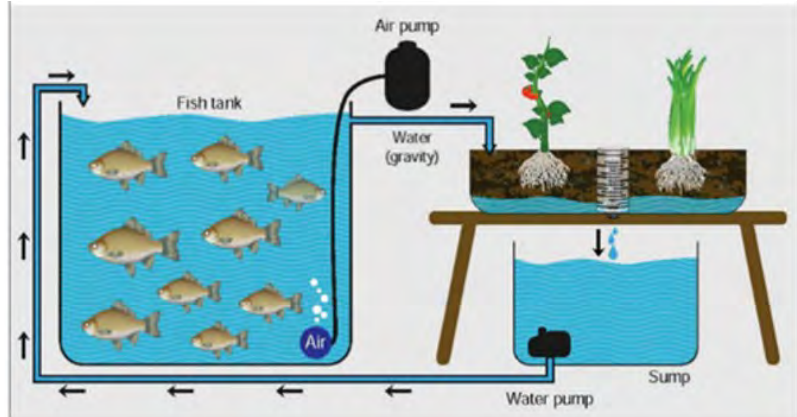
Figure 7. Simple aquaponic unit (Food and Agriculture Organization of the United Nations Rome, 2014).